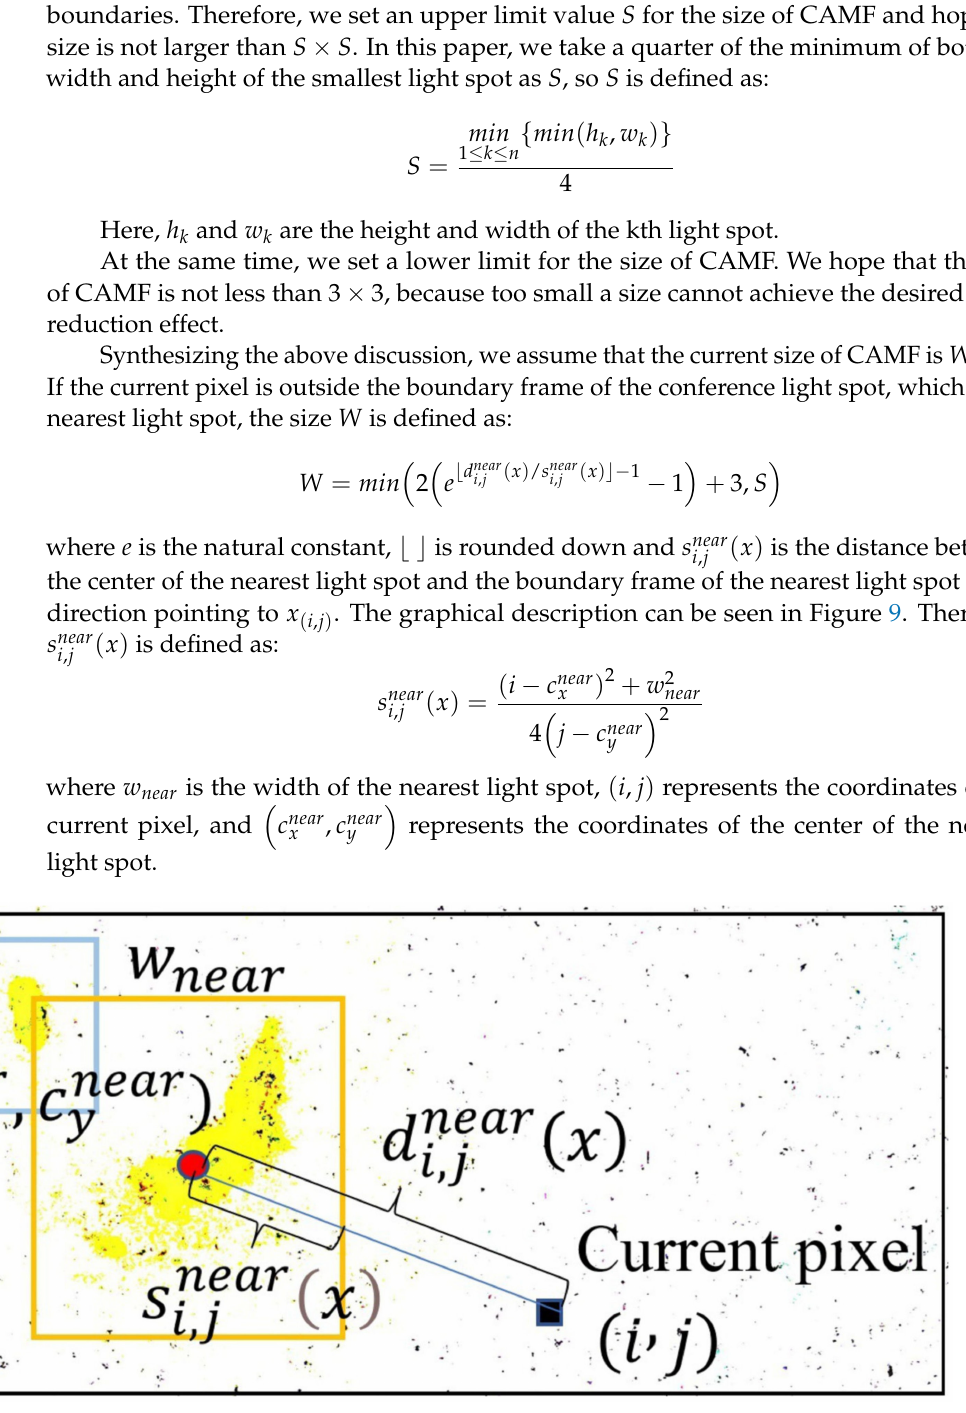
( x ) and d near ( x ) i , j i , j